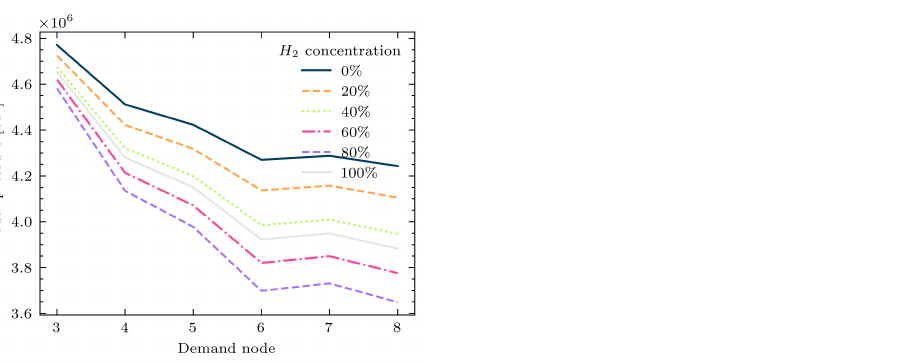
Figure 7. Pressure at demand nodes with respect to different hydrogen concentrations in the network.